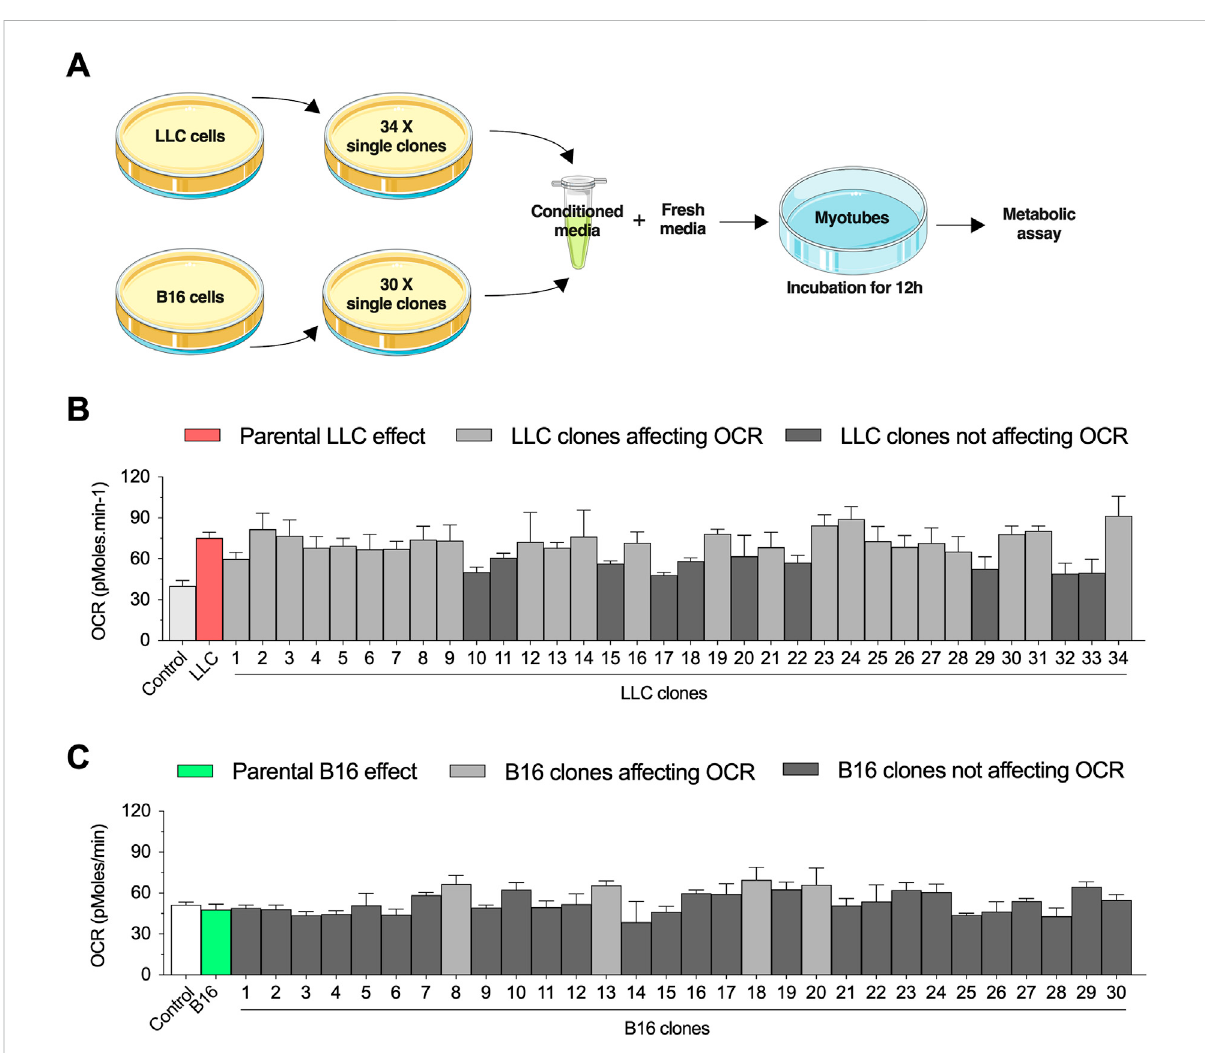
FIGURE 1 Selection of conditioned media from Lewis lung carcinoma (LLC) and B16-F10 melanoma (B16) single clones to challenge primary mouse myotubes. (A) Experimental design to challenge myotubes with LLC-conditioned media. All experiments are conducted by diluting the conditioned media withfreshmedia (ratio 1:1 with ideal fi nal serum concentration)to avoid deprivation of critical nutrients. (B,C) :Basal oxygen consumption rate (OCR) in myotubes incubated for 12 h with conditioned media from different LLC (B) and B16 (C) clones. Two control conditions were applied for each cell line: 1) a healthy naïve control condition and 2) a condition treated with conditioned media from the parental cell lines. Dark gray bars indicate the clones that did not reach statistical difference when compared to naïve control condition, while light gray bars indicate the